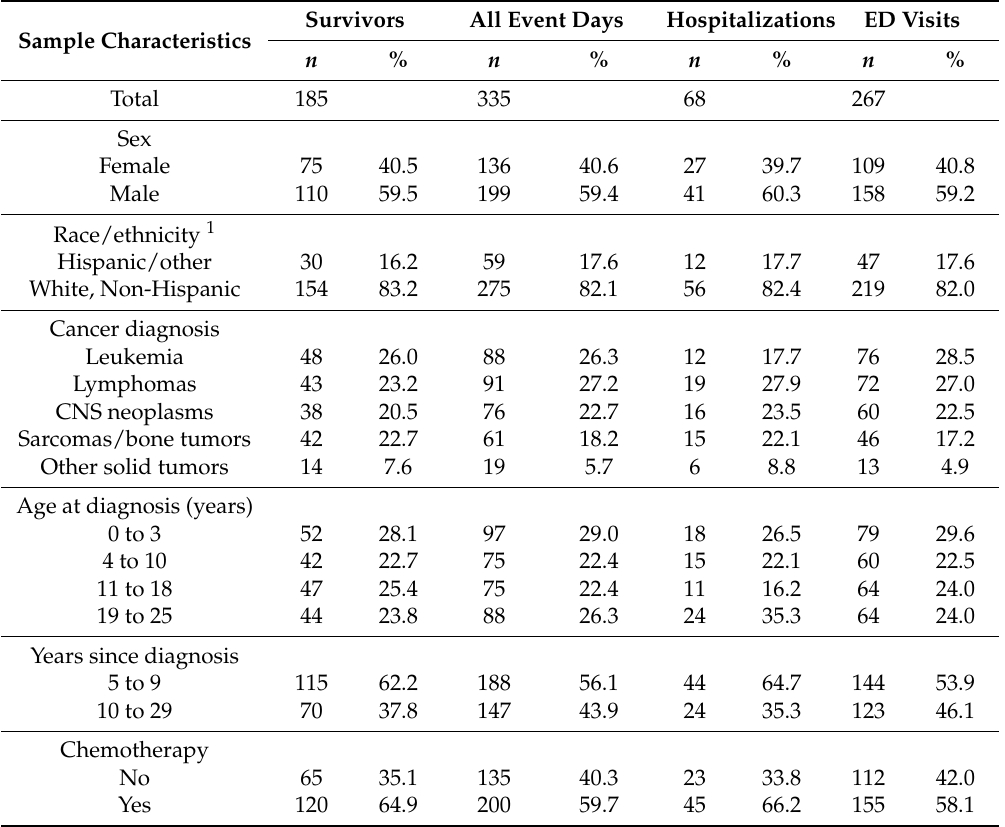
Table 2. Counts of survivors and event days by demographic and clinical